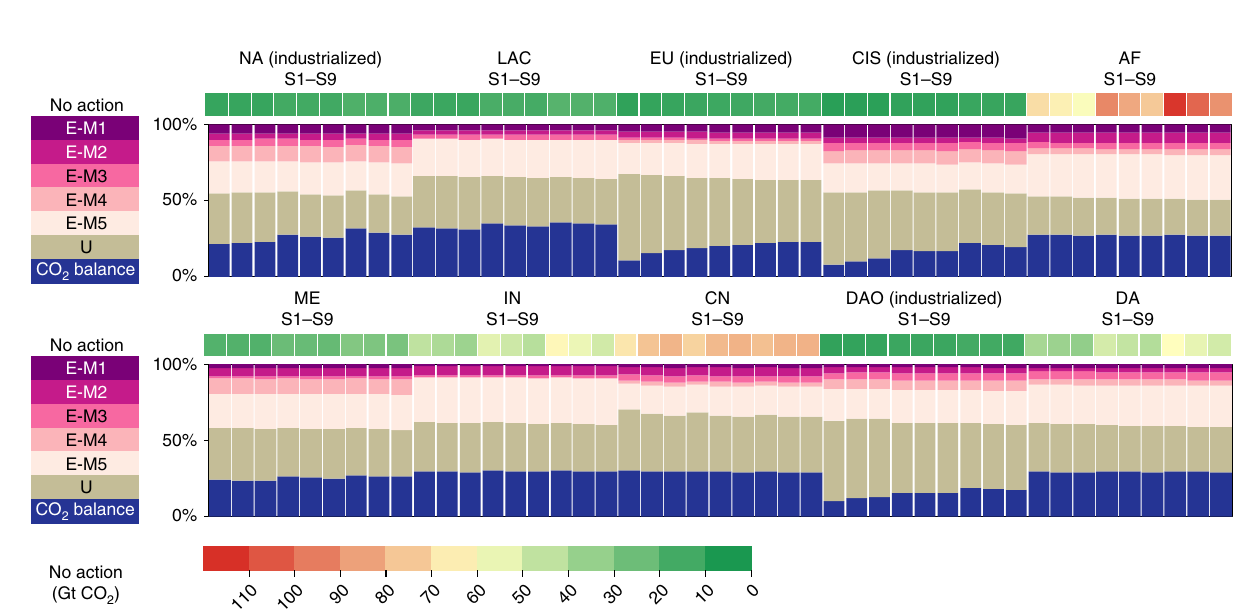
Fig. 2 Decarbonization pathways and supply-side mitigation measures of the global cement cycle across the nine stock dynamic scenarios. a The no- action CO 2 emissions and uptake pathways from 2015 to 2100 coupled with the results of the fi ve supply-side mitigation measures. b The 2015 – 2100 accumulated mitigation potential by the fi ve supply-side mitigation measures and uptake. CO 2 emissions (1.5 °C): the red line represents the calculated CO 2 emissions pathway that is consistent with the 1.5 °C budgets (a 66.7% probability) in the IPCC ’ s special report (see “ Methods ” ). CO 2 balance (no- action): the black line represents the no-action CO 2 balance, that is, no-action CO 2 emissions minus no-action CO 2 uptake. Net CO 2 balance: the brown line represents the net CO 2 balance when the fi ve supply-side mitigation measures are implemented. U-M4: clinker substitution marginally reduces CO 2 uptake in cement-related materials. Acc. accumulated, Low low stock saturation level, Medium medium stock saturation level, High high stock saturation